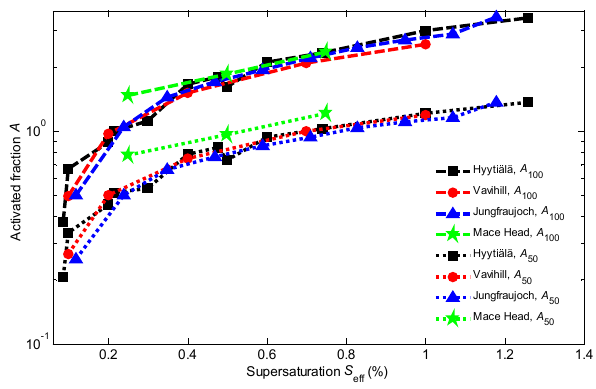
Figure 5. Average effective activated fractions A 100 ( N CCN / N 100 ) and A 50 ( N CCN / N 50 ) as a function of supersaturation S eff for the four long-term measurement